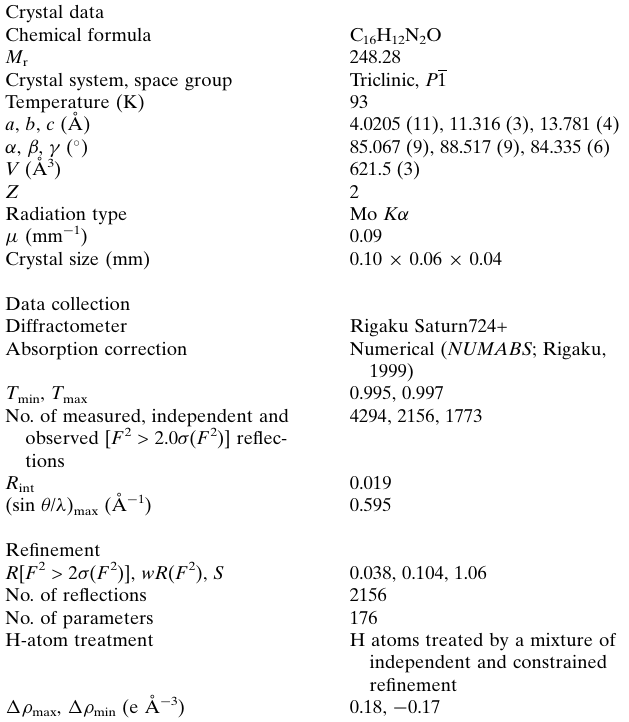
Table 2 Experimental details.